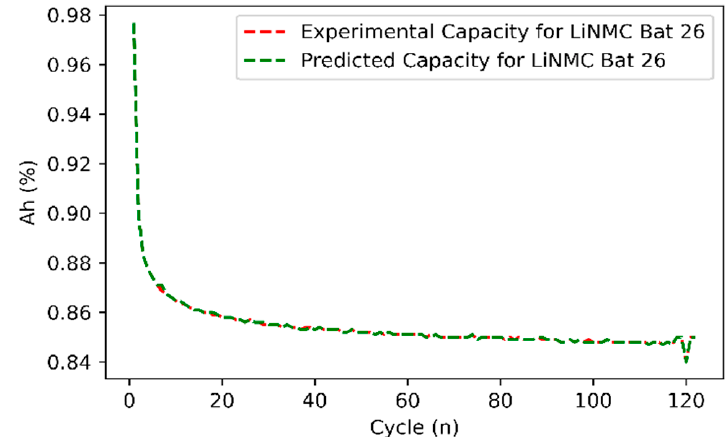
Figure 3. The capacity prediction of battery 25.